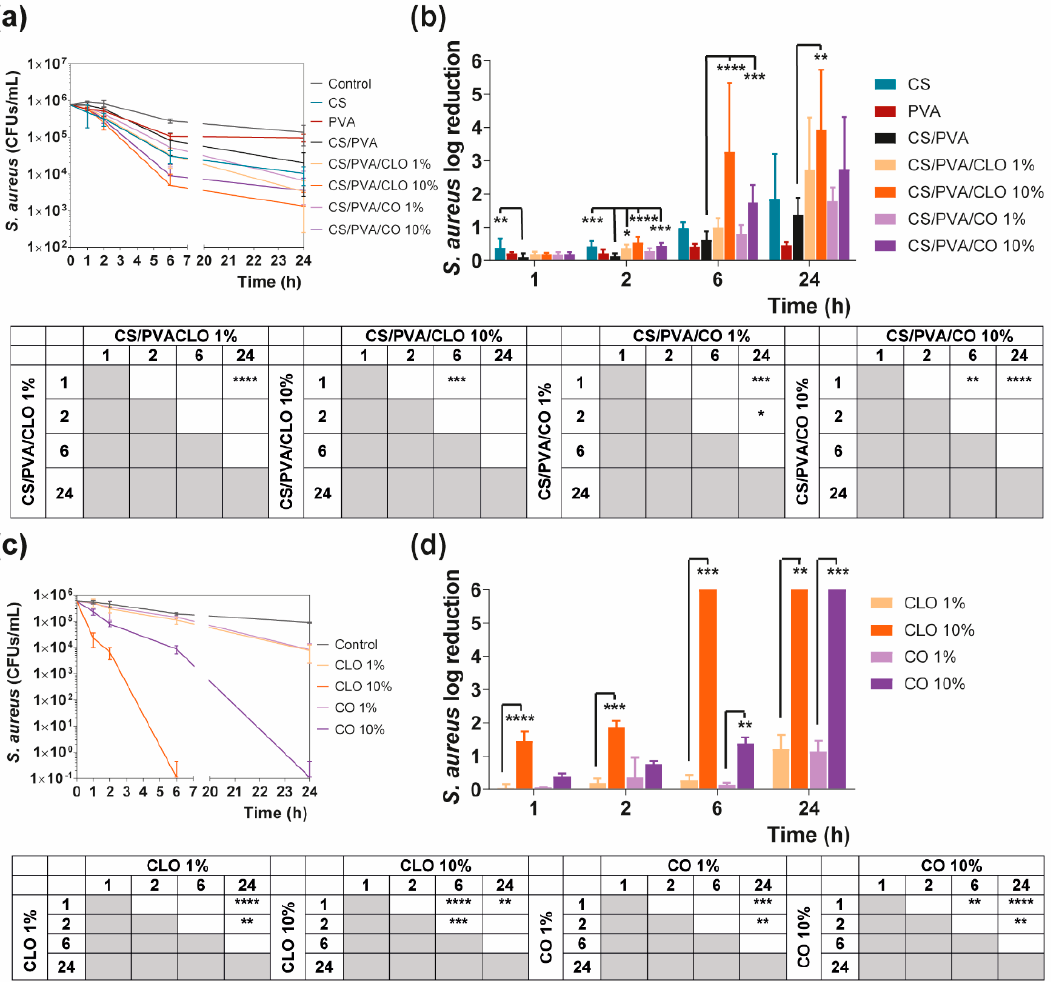
Figure 9. Time–kill curves of ( a ) unloaded and EO-loaded films and ( c ) EOs at film loaded concentration, against S. aureus bacteria, up to 24 h of culture. Positive controls for S. aureus (growth without agent or film) were also conducted (grey line), reaching a maximum value of ≈ 8.9 × 10 6 CFUs/mL after a 24-h culture (data not shown in graphic). S. aureus reduction (calculated as log reduction) of ( b ) the films and ( d ) EOs in relation to control samples. The elimination of 100% of bacteria was considered as log 6. Results are represented as the mean ± SD ( n = 3). Statistically significant differences can be highlighted, * p < 0.05, ** p < 0.005, *** p < 0.001, and **** p < 0.0001, for each sample at each time point in comparison to ( c ) each free EO or to the ( d ) loaded CS/PVA films, using the Kruskal-Wallis test, followed by the Dunn’s multiple comparisons test. The evolution over time of each EO and EO-loaded film’s AM action was also examined and shown in a table format for clarity.